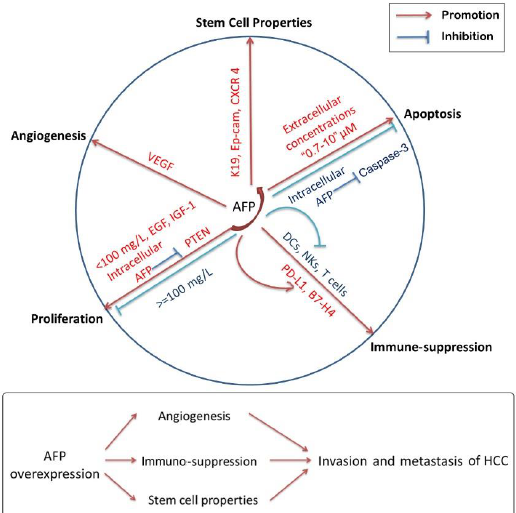
Figure 2. Effects of AFP on the tumorigenesis and progression of HCC. AFP shows multi-effects on HCC, including cell proliferation, cell apoptosis, tumor immunology, stem cell properties, angio- genesis and so on. Overexpression of AFP promotes the invasion and metastasis of HCC via the immuno-suppression and the improvement of stem cell properties as well as angiogenesis. Interest- ingly, AFP has complicated controversial effects in cell proliferation and apoptosis according to the concentration of AFP and the status of AFP that is circulating or cytoplasmic. Table 2. Comparison between circulating (extracellular) and cytoplasmic (intracellular) AFP on the effects of the tumor- igenesis and progression of HCC. Regulations